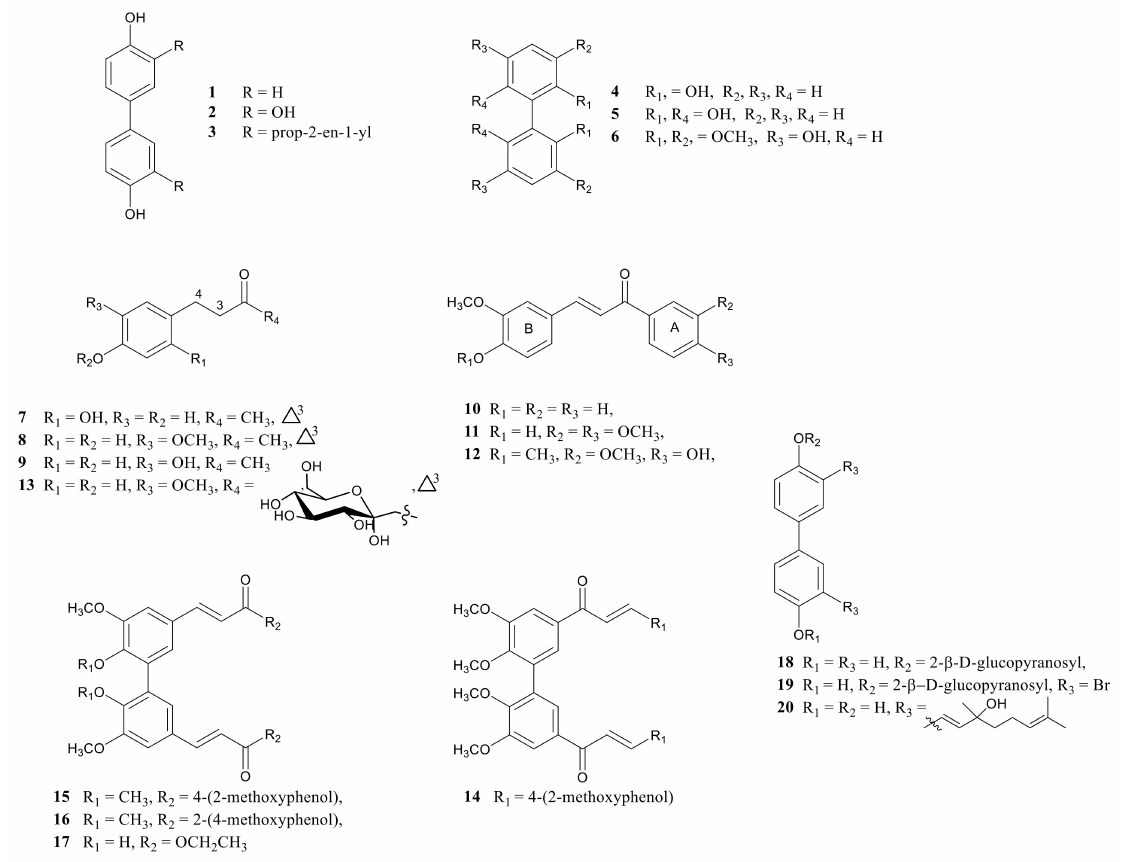
Figure 2. Hydroxylated phenylpropanoids and biphenols